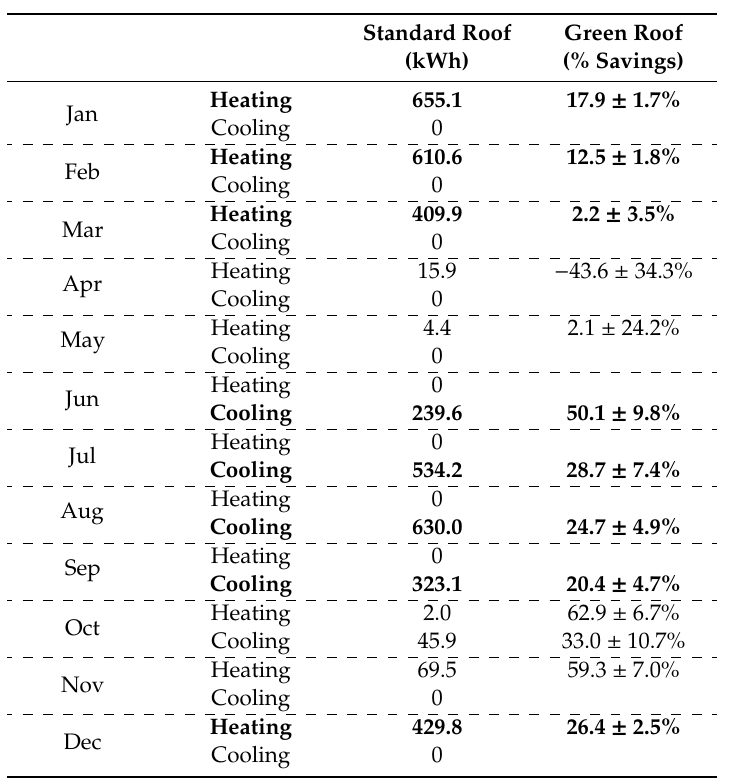
Table 4. Monitoring results of the green roofs six